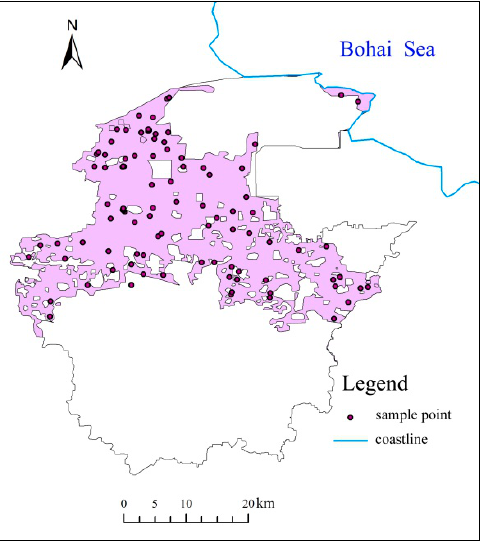
Figure 1. The sketch map of the sample point in Shouguang.